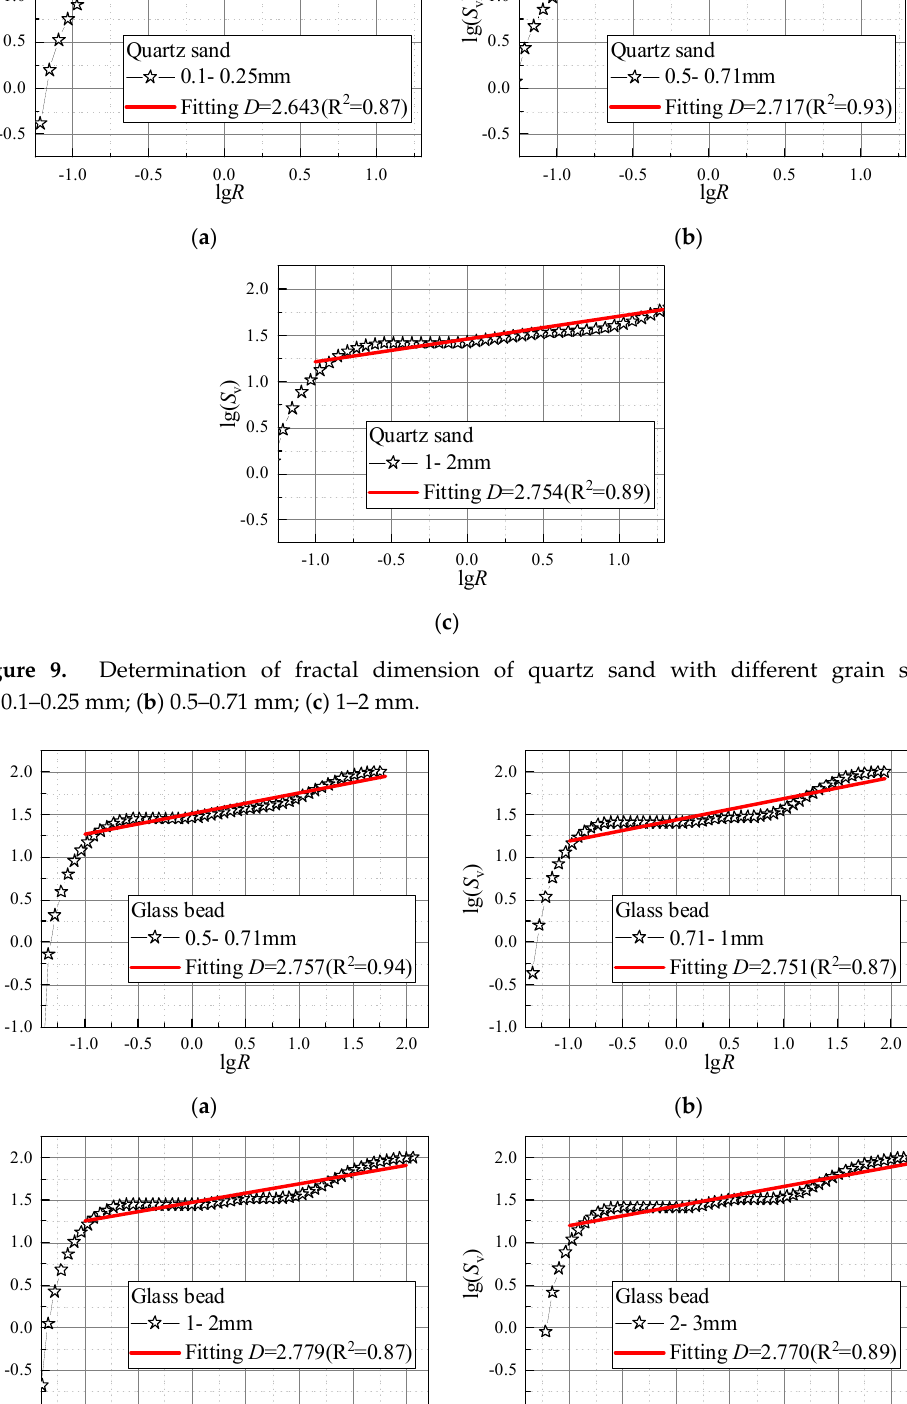
Mean grain size (mm) Test data Calcareous sand Quartz sand Glass bead Regression Calcareous sand Quartz sand Glass bead Figure 11. Fractal dimensions of the tested materials with different grain sizes. It is widely acknowledged that the determination of the fractal dimension plays an important role in predicting the physical and mechanical properties of geomaterials [45,46]. Huang et al. [45] quantified the fractal characteristics of the pore structure of shale